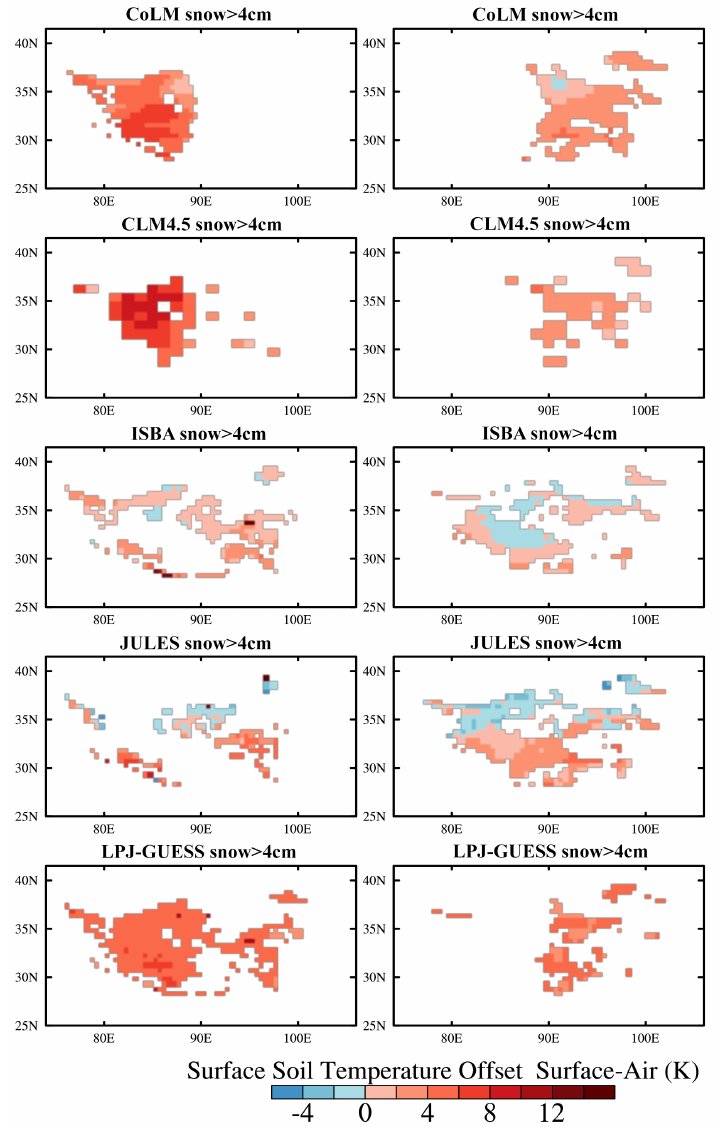
Figure 9. Mean surface temperature offset (difference in mean winter temperatures between surface soil and air, averaged over 1980–2000). Left column is for snow depth > 4cm, right column shows regions with snow depth < 4cm. Warm colors indicate soil is warmer than air